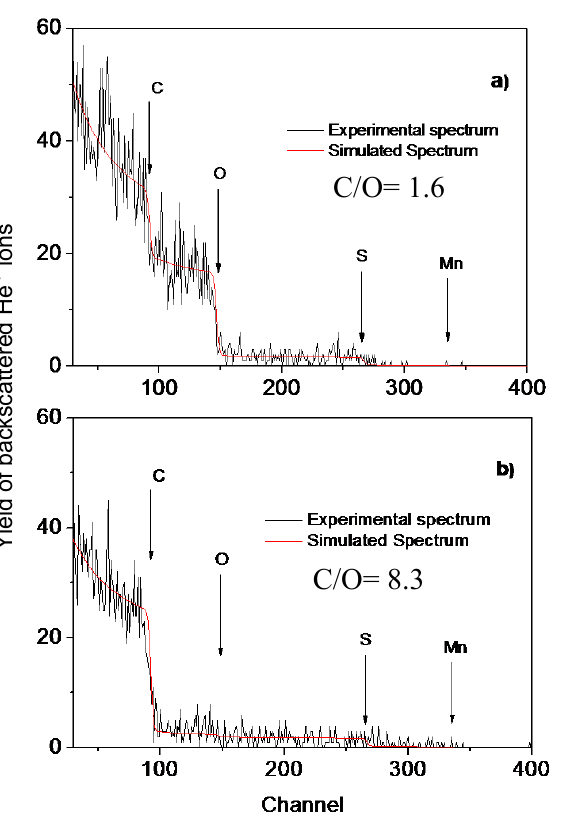
Fig. 5. RBS spectra relative to the pristine GO (a) and to the laser irradiated GO (b).